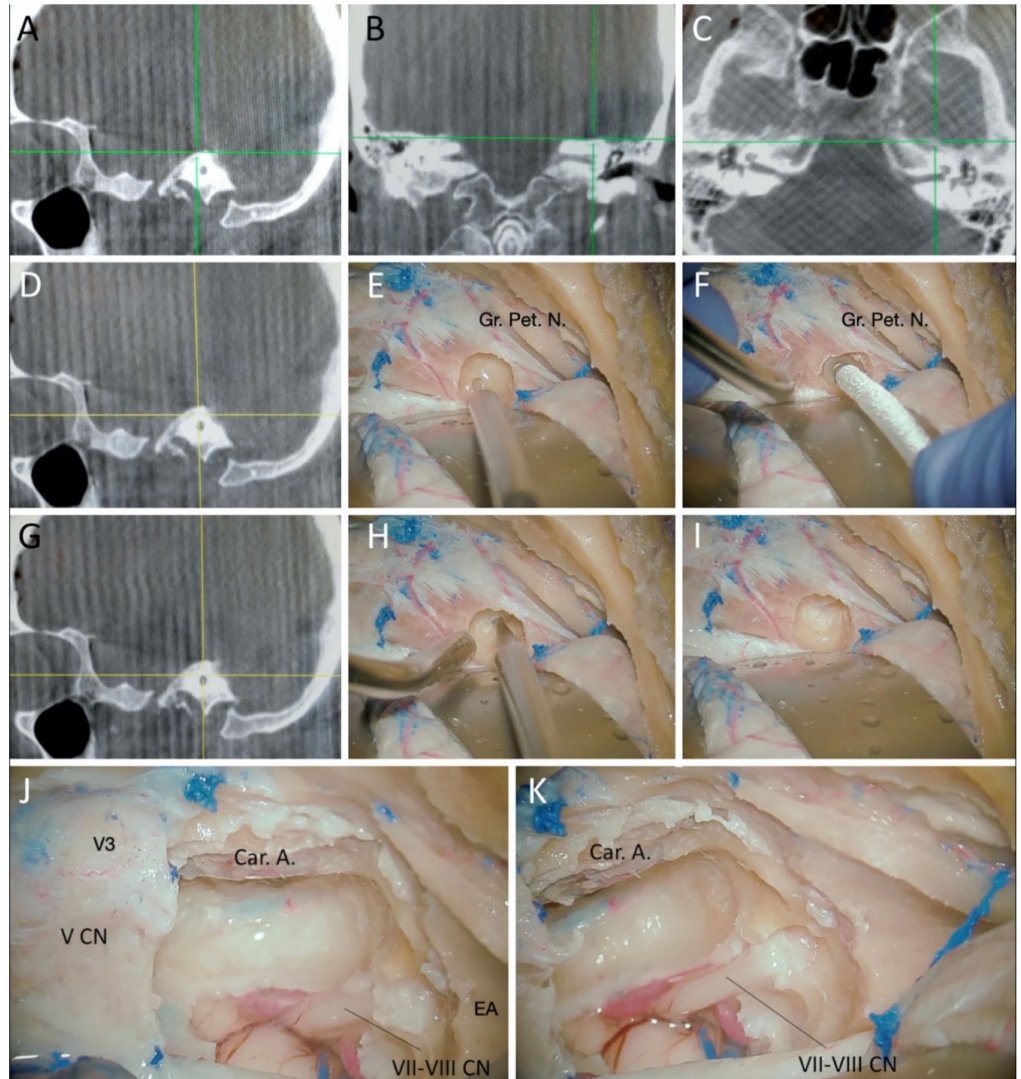
Figure 4. ( A – D ) Navigation screenshots showing the trajectory of the drilling towards the internal acoustic meatus in the sagittal ( A , D ), coronal ( B ), axial ( C ). ( E , F ) Tip of the probe marking continuously the position of the drilling of the bone between the greater petrosal nerve and the eminentia arcuata in the navigation screen. ( G ) Navigation screenshots in sagittal view, revealed as the drilling approximates the dura of the internal auditory canal. ( H , I ) Tip of the probe marking the dura of the internal auditory canal. ( J ) Final exposure of the approach, with the following limits: the posterior margin of V3, medial margin of the internal carotid artery, and anterior margin of the eminentia arcuata. The dura of the internal auditory canal was opened to expose the VII-VIII complex. ( K ) Final view of the intradural exposure of the approach. Car. A.: Internal carotid artery; EA: Eminentia Arcuata; Gr. Pet. N.: Great Petrosal Nerve; IAC: Internal Auditory Canal; V CN: Trigeminal cranial nerve; V3: Mandibular division of the trigeminal nerve; VII-VIII CN: facial and vestibulocochlear cranial